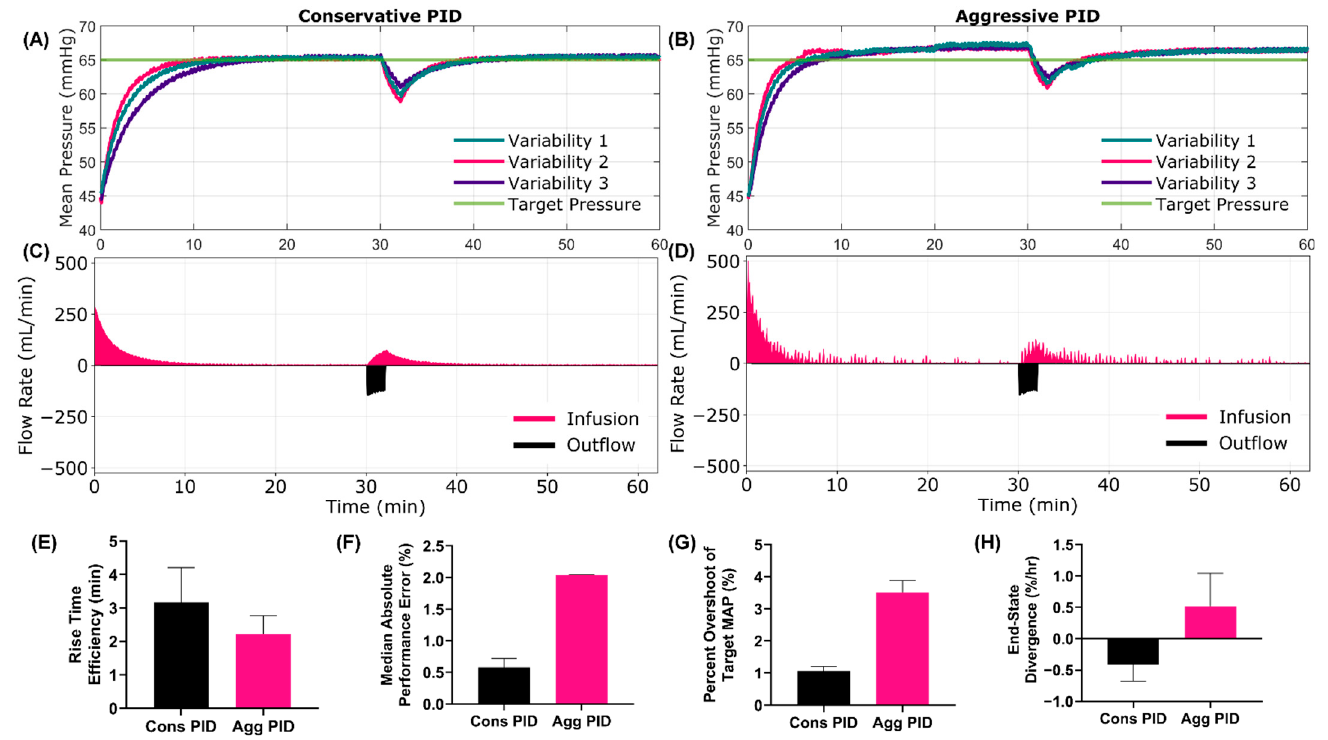
Figure 2. Scenario 1 Testing Results . Scenario 1 began at a low starting MAP with no active bleed, which mimicked tourniquet usage to stop an extremity bleed. At 30 min, the tourniquet slipped which resulted in a high hemorrhage rate that stopped after 120 s. WB infusate was used for this scenario. Results for the conservative ( A , C ) and aggressive ( B , D ) tuned PID are shown for ( A , B ) MAP and ( C , D ) infusion and outflow rates versus time as the controller tried to reach a target MAP of 65 mmHg. For MAP plots, each of three subject variability runs are plotted individually, while a single representative run is shown for the inflow/outflow plots. Average controller performance metrics for ( E ) rise time efficiency, ( F ) MDAPE, ( G ) target overshoot and ( H ) end-state divergence are shown for both controller tunings for this scenario. Error bars denote standard deviation ( n = 3).